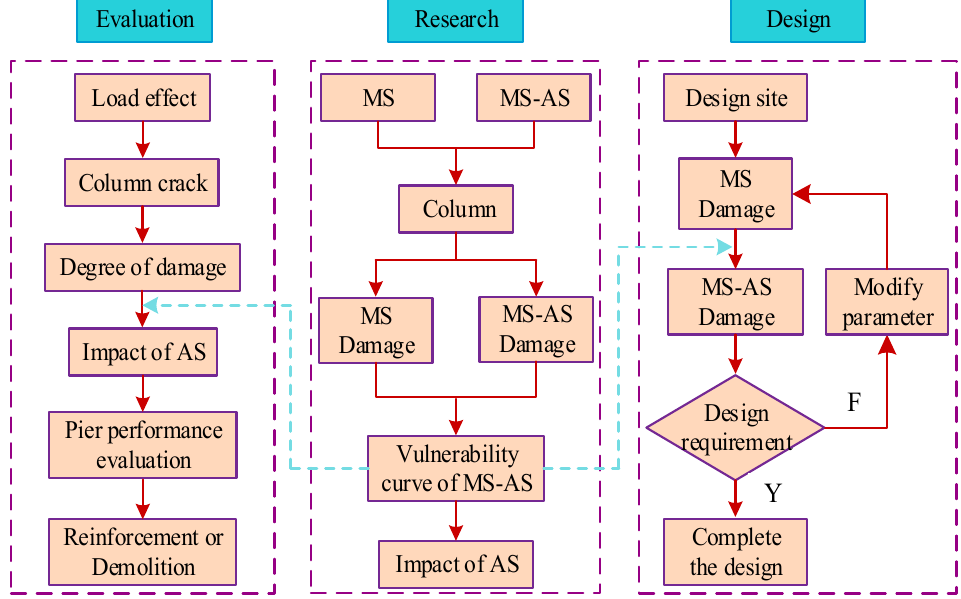
Figure 1. Research content and significance.